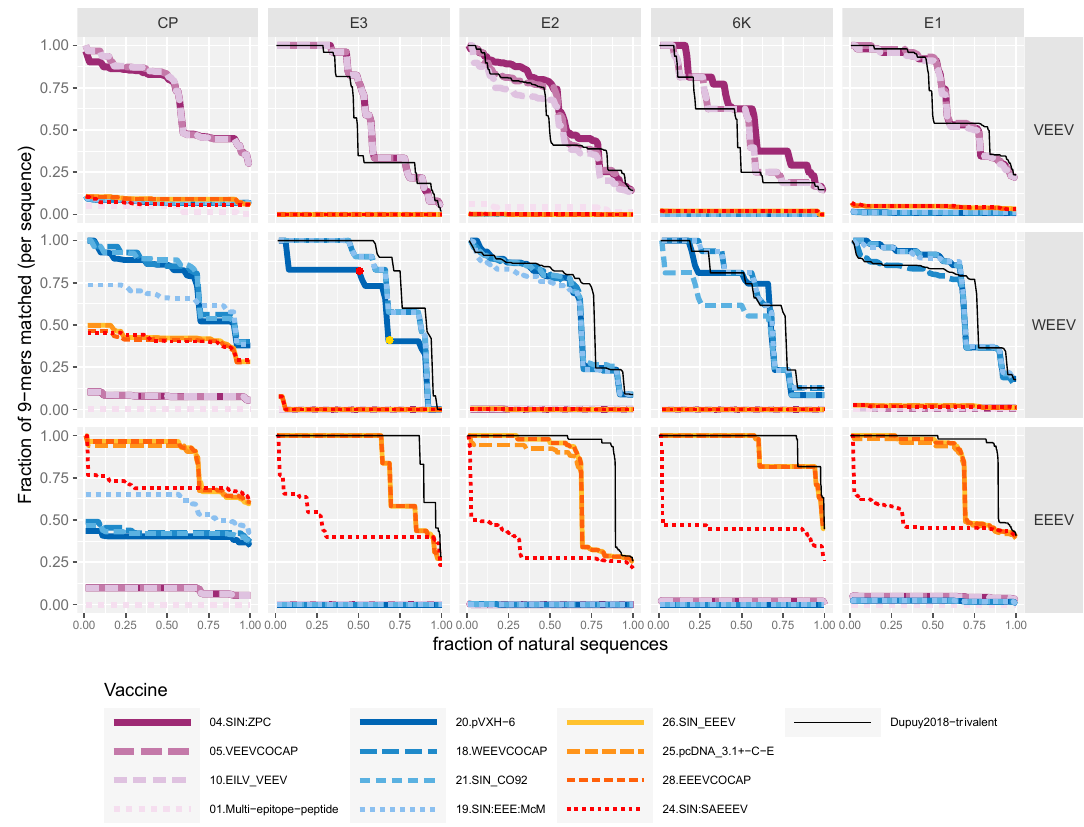
Figure 3. Matching of potential linear epitopes (9-amino-acid fragments) in natural sequences by selected vaccine candidates. Highly similar sequences were removed from an alignment of all available VEEV-clade, WEEV-clade, and EEEV-clade sequences in GenBank in November 2019. For each vaccine, the fraction of vaccine-matched 9-mers, “9-mer coverage”, was computed for each sequence; sequences were plotted in descending rank order of coverage. For example, for the E3 protein, vaccine pVXH-6 covers ~50% of WEEV isolates at a level of 82% of 9-mers or better (those to the left of the red dot), whereas 32% of isolates (those to the right of the gold dot, x -axis value 0.68 and above) are covered at a level of 41% or less. Colors identify candidate vaccines as in Figure 2.